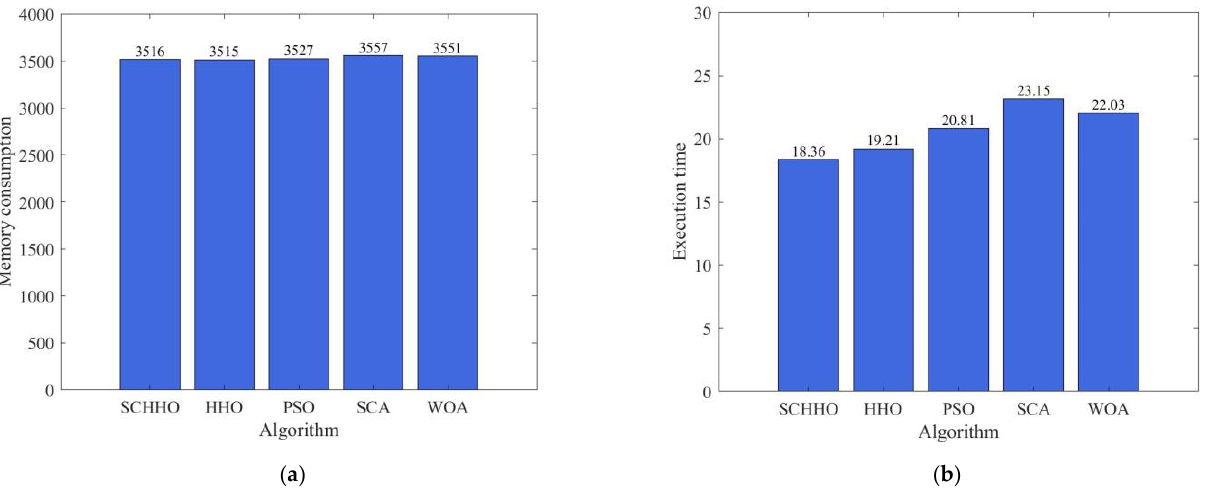
Figure 9. Memory consumption and execution time comparison. ( a ) memory consumption. ( b ) execution time.